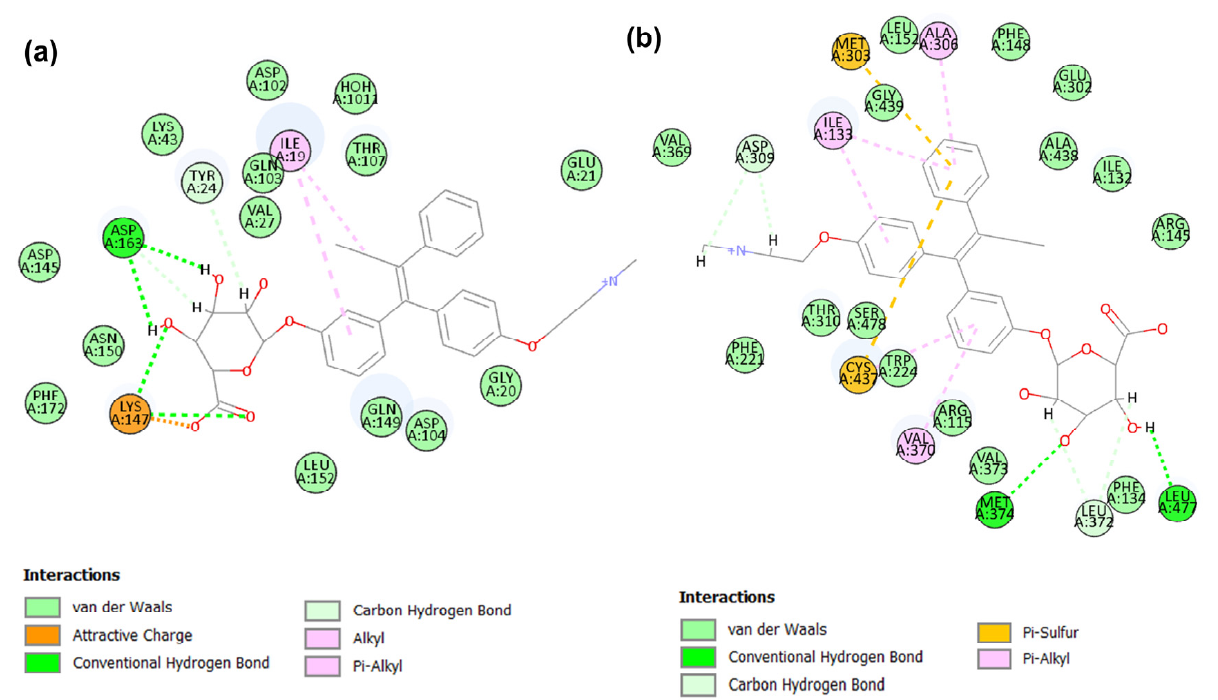
Figure 7. The 2D plot of candidate 1 in CDK6 ( a ) and aromatase ( b ) at the binding site.